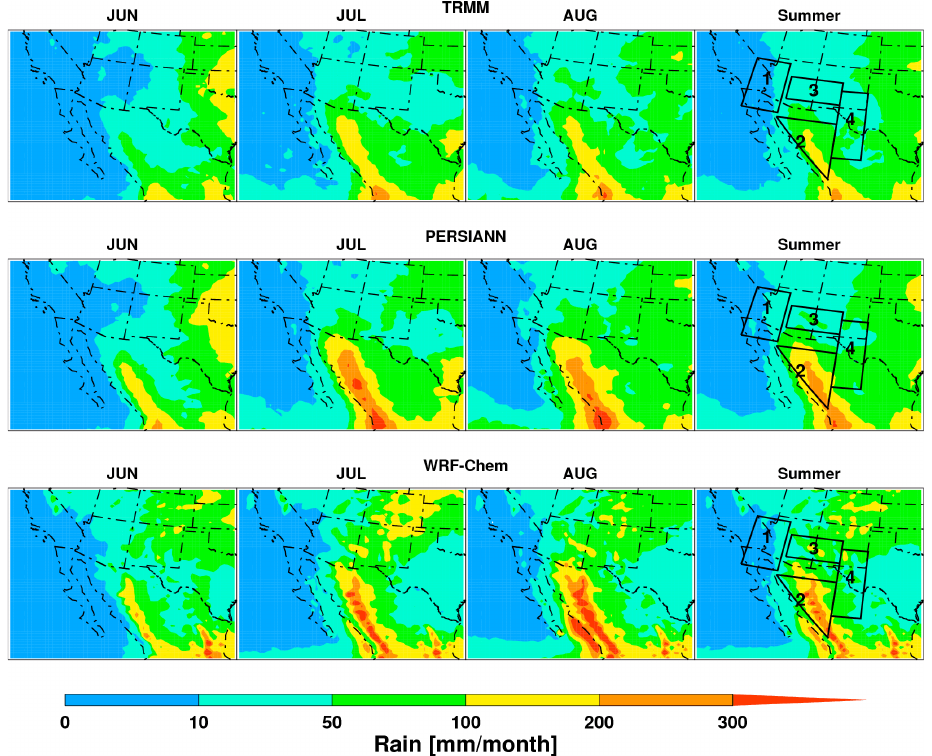
Fig. 6. Spatial distributions of precipitation over the NAM region from TRMM and PERSIANN data and WRF-Chem simulations in Figure 6 Spatial distributions of precipitation over the NAM region from TRMM and 4 June, July, August, and summer averaged for 2000–2009. Four sub-regions are defined in the black boxes (rightmost column): Region 1 (DESERT), Region 2 (CORE), Region 3 (AZNM), and Region 4 (TXNM). PERSIANN data and WRF-Chem simulations in June, July, August, and summer 5 (Fig. 2) with the highest forcing of − 1.25 W m − 2 over averaged for 2000-2009. Four sub-regions are defined in the black boxes (rightmost 6 column): Region 1 (DESERT), Region 2 (CORE), Region 3 (AZNM), and Region 4 7 (TXNM). 8